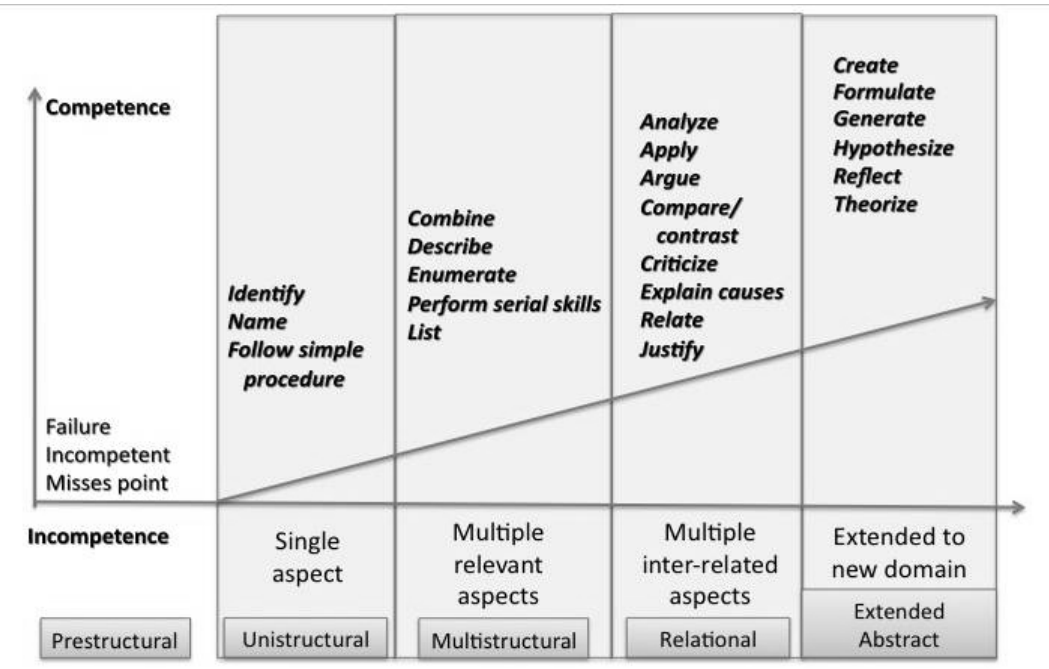
Figure 1 . Constructive alignment (Biggs & Tang,